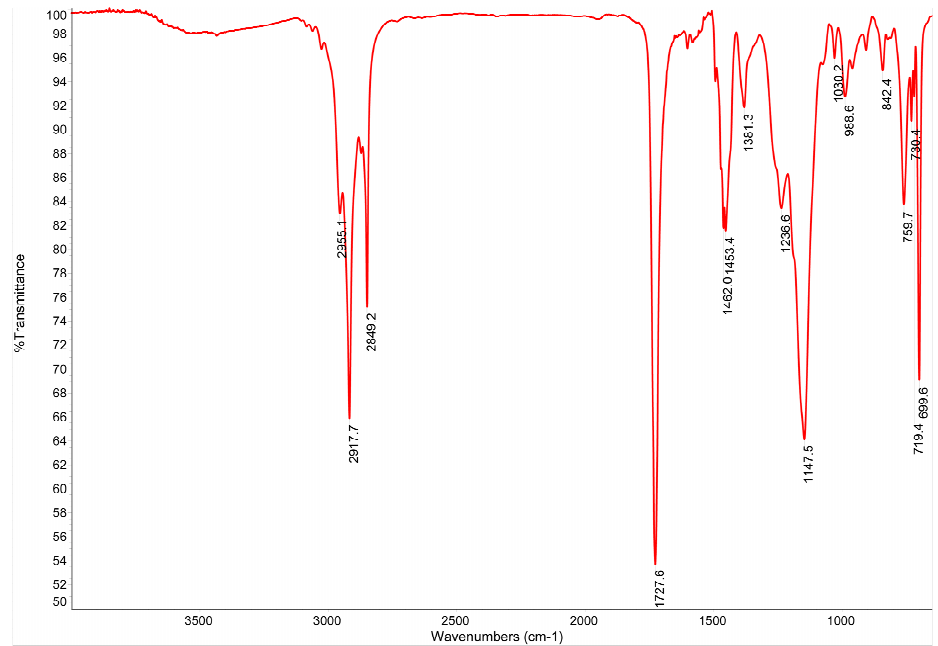
Figure A2. FTIR spectrum for the SA-B commercial coating. Additionally, the same dispersion coatings were DSC-TGA analyzed. The solid phase was obtained by evaporation of the solvent and then tested.